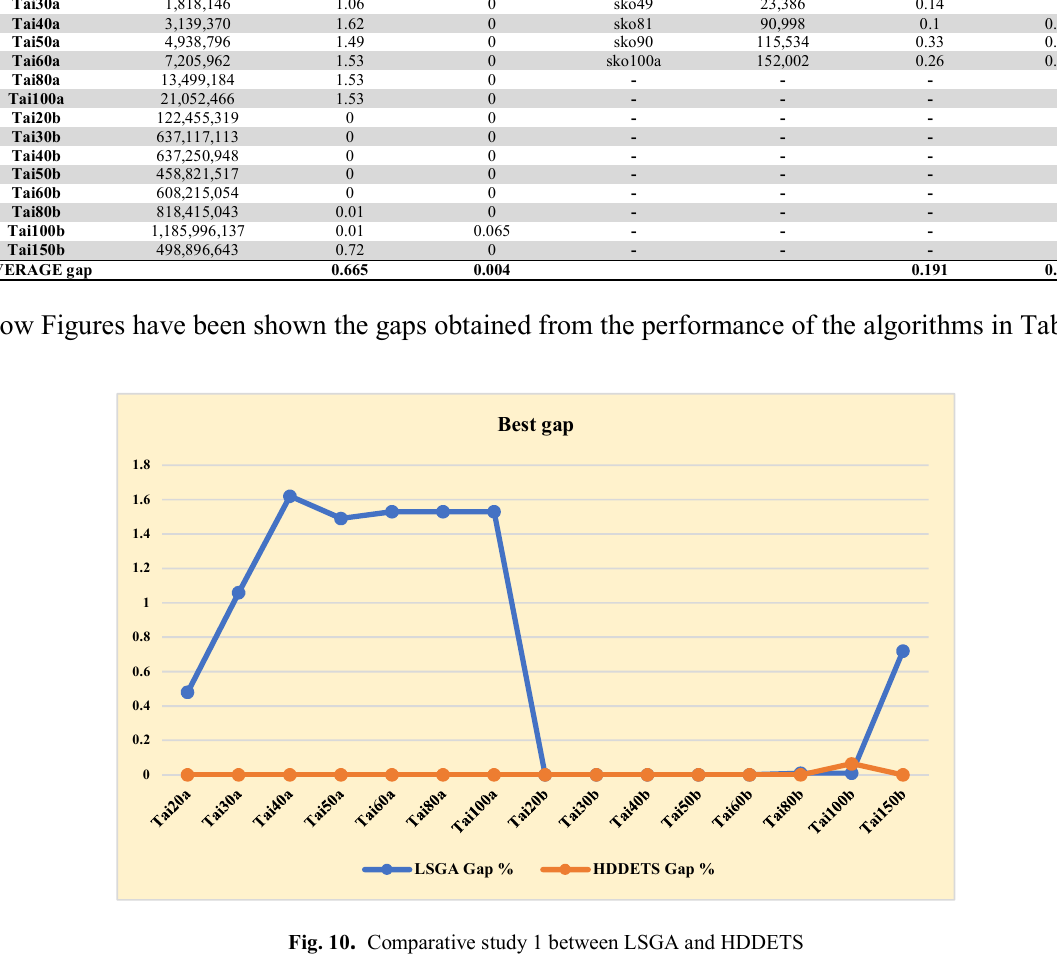
Fig. 10 . Comparative study 1 between LSGA and HDDETS